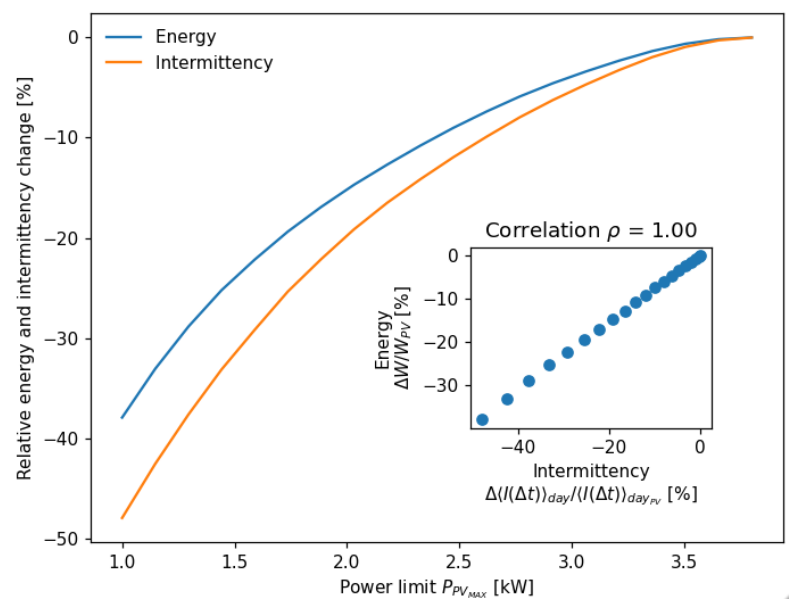
Figure 30. Relative change in energy and intermittency as a function of power limit